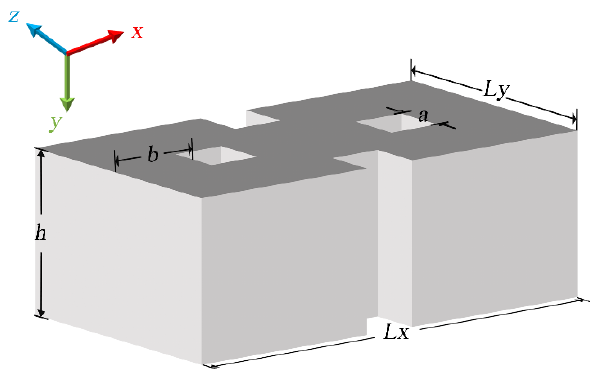
Figure 1. Schematic diagram of the structure of the OH-SiNB.